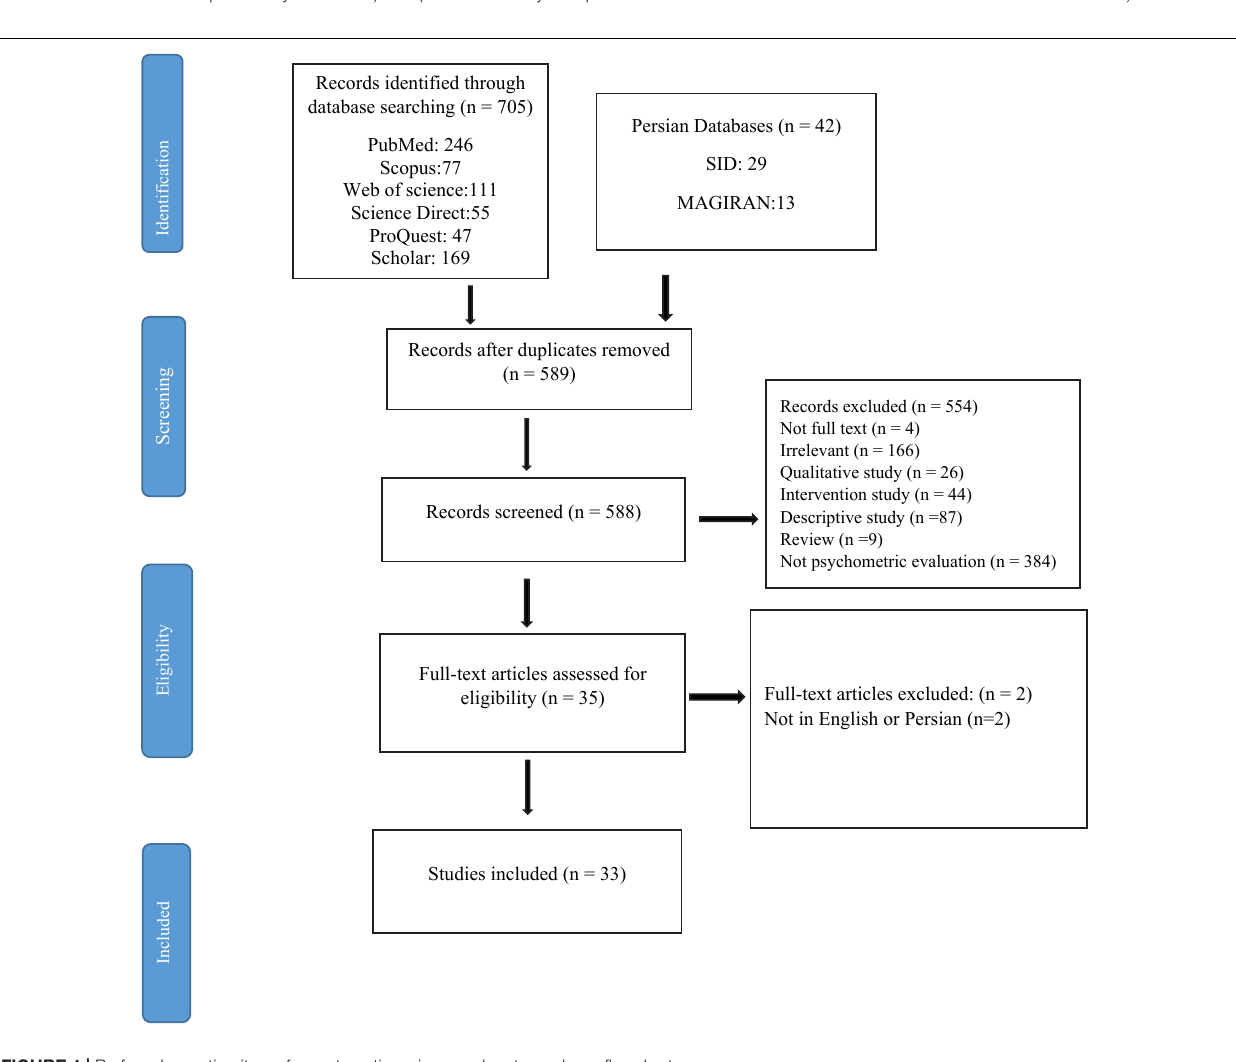
FIGURE 1 | Preferred reporting items for systematic reviews and meta-analyses